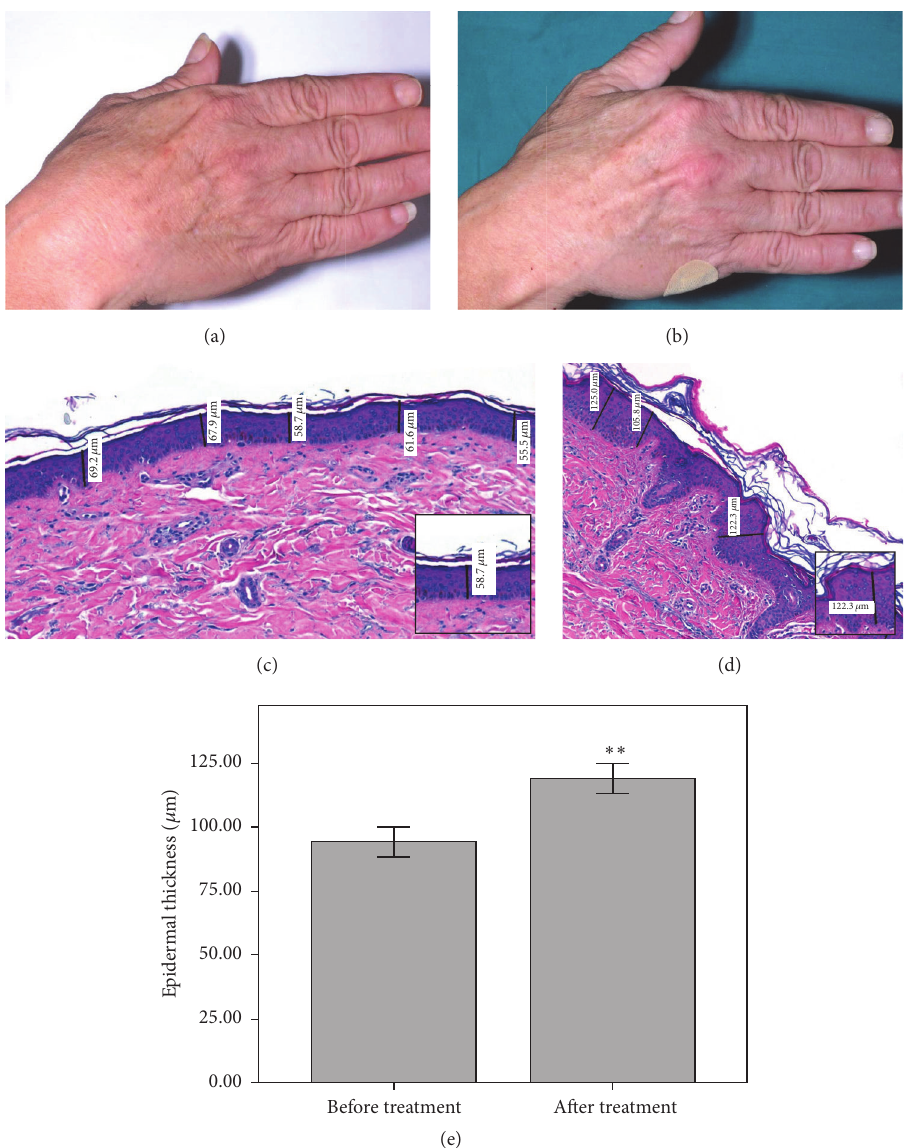
Figure 1: Clinical images before (a) and after treatment (b) showing more brightness and less rhytides after treatment. Hematoxylin-eosin imagebefore(c)andaftertreatment(d),showingtheimprovementonepidermalthickness(40xmagnification).Epidermalthicknessincreases by 26.3% after treatment compared to baseline ( ∗∗ 𝑝 ≤ 0.01 )